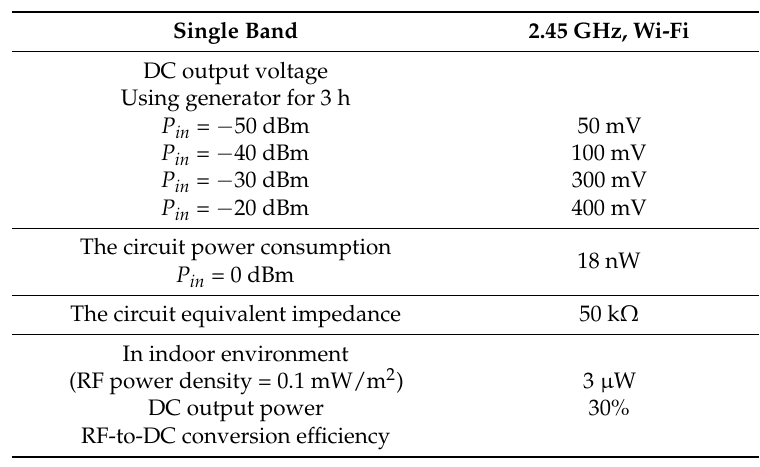
Table 5. The proposed system key features.